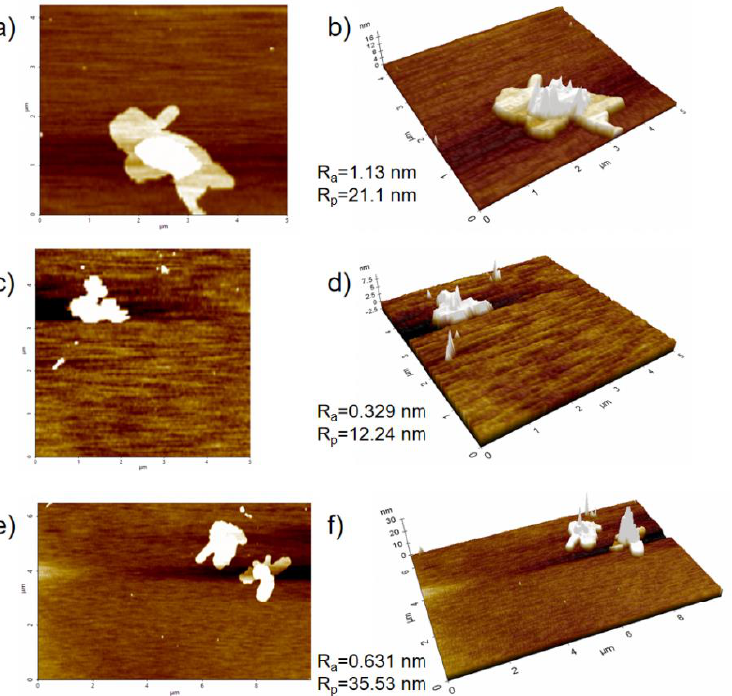
Figure 6. AFM images of PPy/CNCs ( a ) CNC; ( b ) Three dimensions of CNC; ( c ) PPy; ( d ) Three di- mensions of PPy; ( e ) PPy/CNCs; ( f ) Three dimensions of PPy/CNCs.